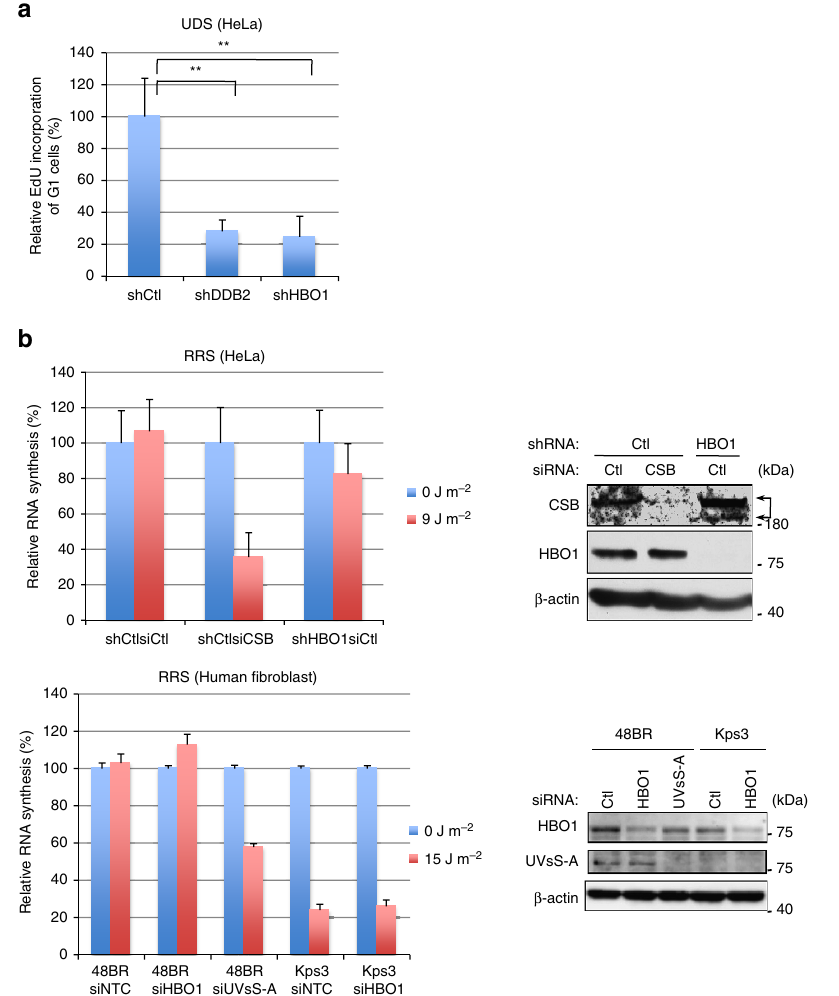
Figure 2 | HBO1 is required for GG-NER but not TC-NER. ( a ) Depletion of HBO1 caused defects of unscheduled DNA synthesis (UDS) in HeLa cells. Cells were irradiated with 15Jm (cid:2) 2 ultraviolet and incubated for 3h with EdU. Ultraviolet damage-dependent EdU incorporation of G1 cells was quantified and is shown as % of shCtl cells. Cells ( n ¼ 1,500) from nine independent experiments; error bars indicate means ± s.d. ** P o 0.01 (Student’s t -test). ( b ) Depletion of HBO1 did not affect recovery of RNA synthesis (RRS) after ultraviolet irradiation. HeLa shCtl or shHBO1 cells (left upper) and normal or UVsS-A fibroblasts (left bottom) were transfected with indicated siRNA. RRS assay was performed as described in Methods. Relative RNA synthesis is shown as % of mock irradiated. Depletion of CSB and HBO1 from HeLa and UVsS-A and HBO1 from fibroblasts was confirmed by western blotting (right). Cells ( n ¼ 300) from three independent experiments; error bars indicate means ±